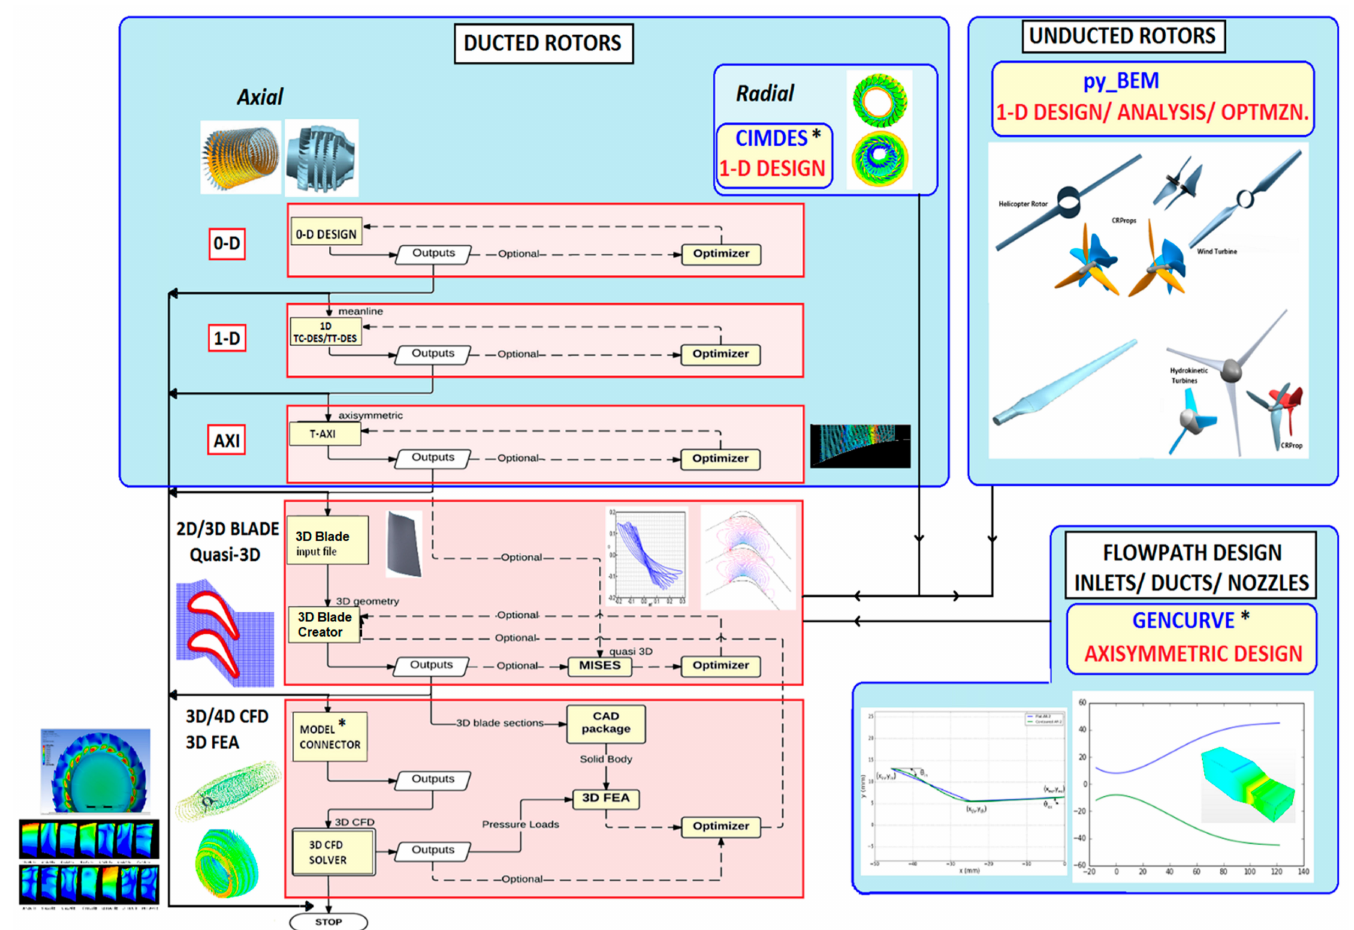
Figure 1. Complete process flowchart of the developed MDAO framework for ducted axial and radial turbomachines, and unducted rotors from low to high fidelity (* general